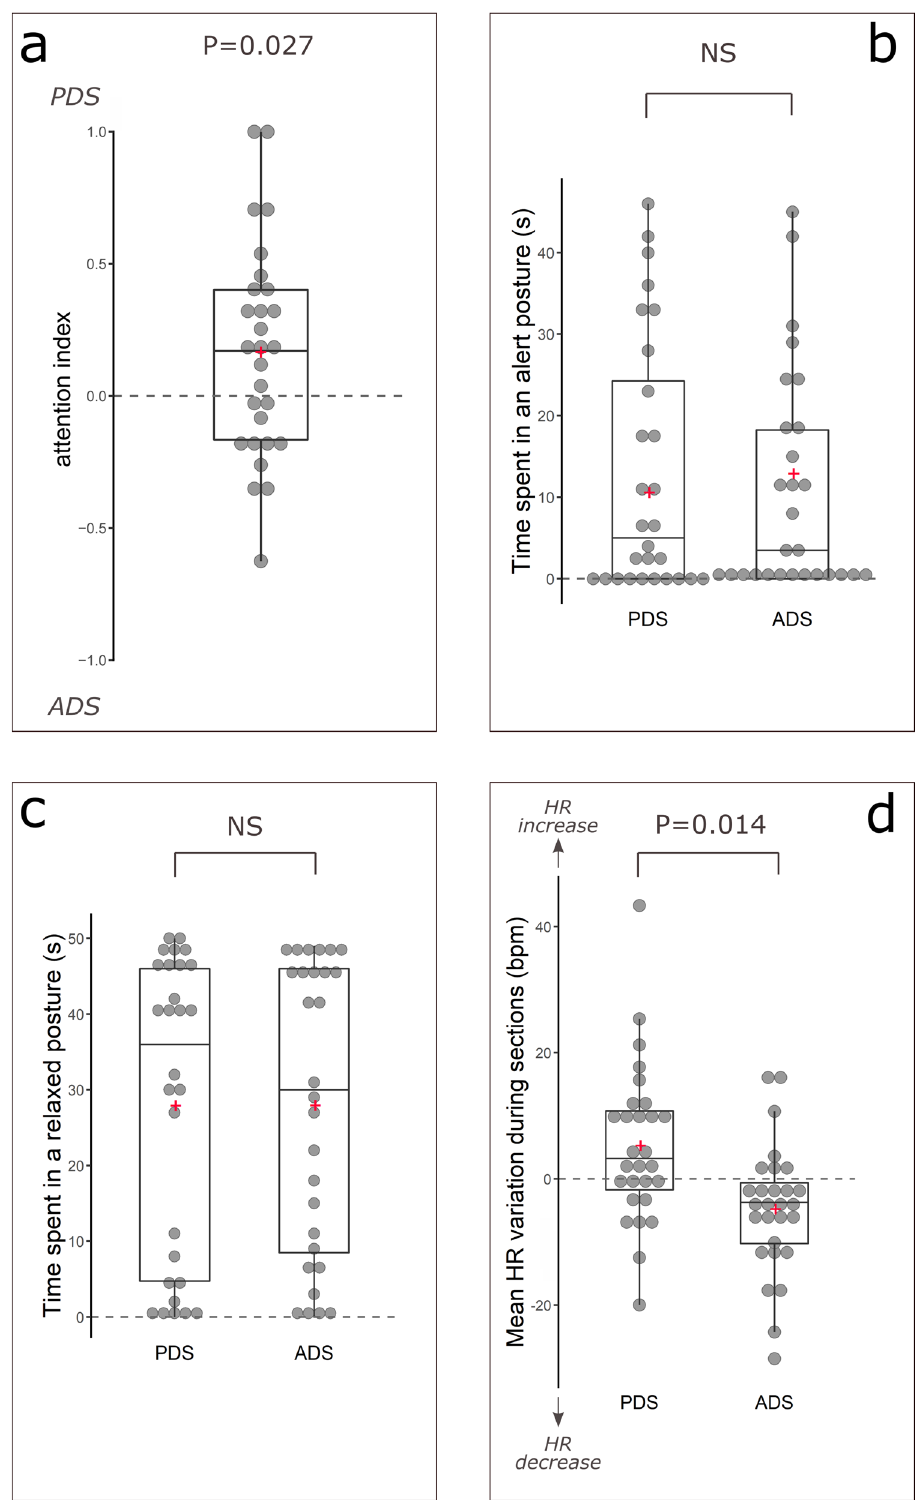
Figure 1. Horses’ behavior and heart rate variations during PDS and ADS. Boxplots showing median, first and third quartiles;. Grey dot: individual results (N = 28); Red Plus symbol: mean. Wilcoxon tests, NS not significant. ( a ) Attention index: (A PDS -A ADS )/(A PDS + A ADS ) with A PDS the time spent being attentive to the screen during PDS sections, and A ADS during ADS sections. ( b ) Time spent in an alert posture when ADS or PDS was projected (s). ( c ) Time spent in a relaxed posture when ADS or PDS was projected (s). ( d ) Mean difference in heart rate between the last five and the first five seconds of the sections when ADS or PDS was projected